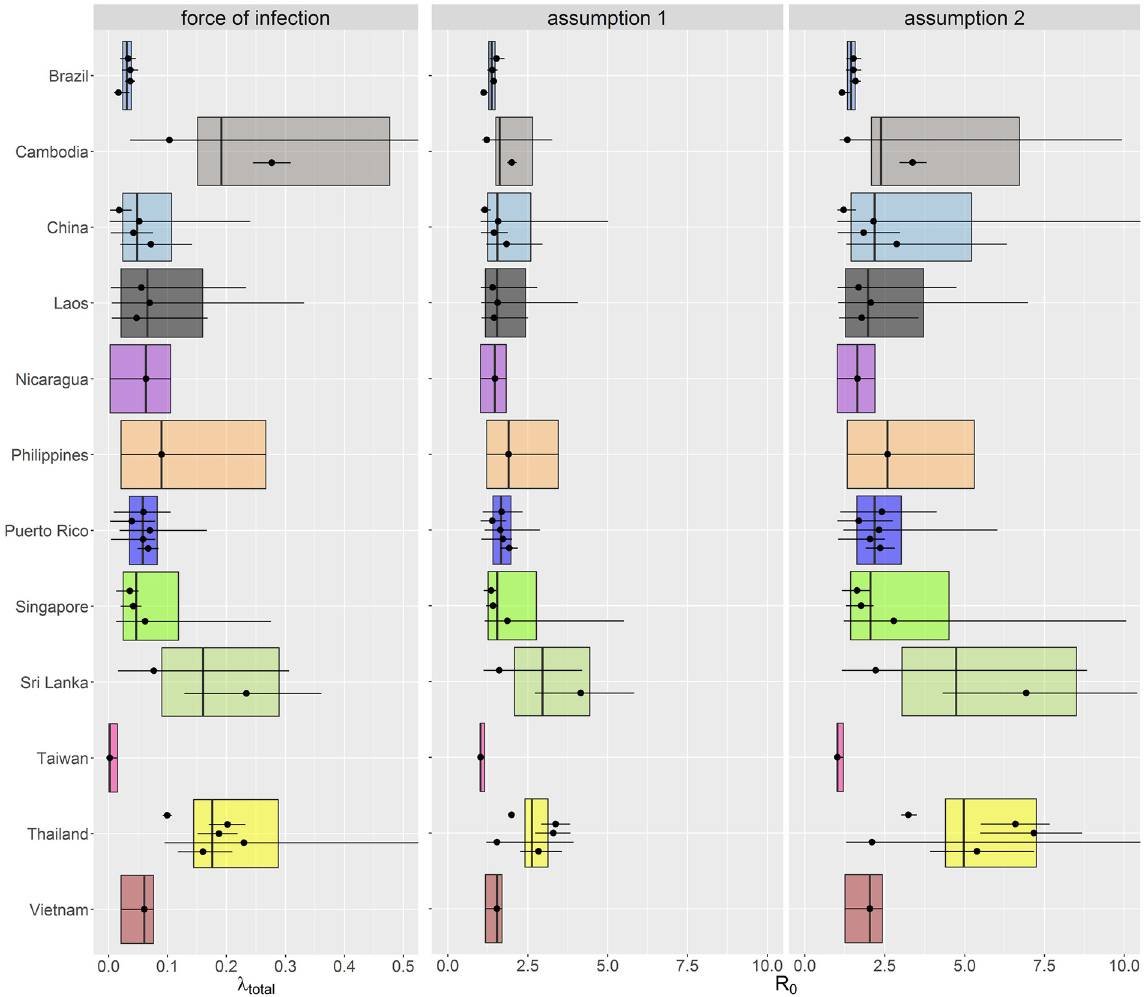
Fig 2. Total force of infection and corresponding R 0 estimates from the model fitted to the incidence data grouped by country. Each dot represents the posterior median estimate and the error bars show the 95% CrI for each dataset. The box represents the country-specific central estimate calculated by taking the mean values of the MCMC output for each country (the line and limits of the box represents the posterior median and the 95% CrI respectively). R 0 assumption one: complete protection acquired upon quaternary infection, assumption two: complete protection reached after secondary